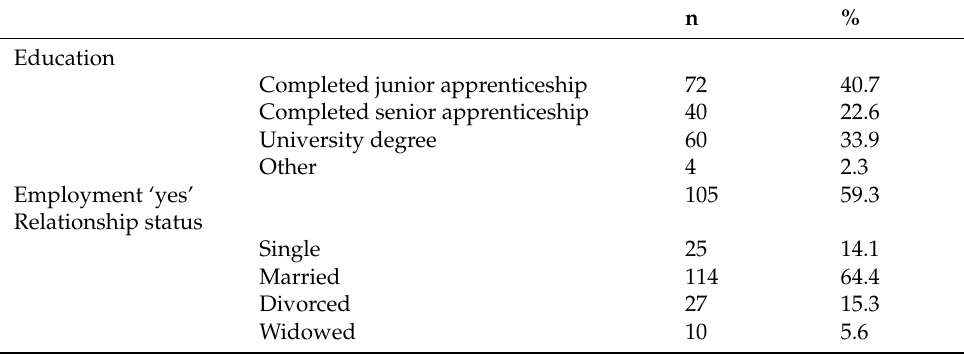
Table 1. Sociodemographic data and patient characteristics ( N =